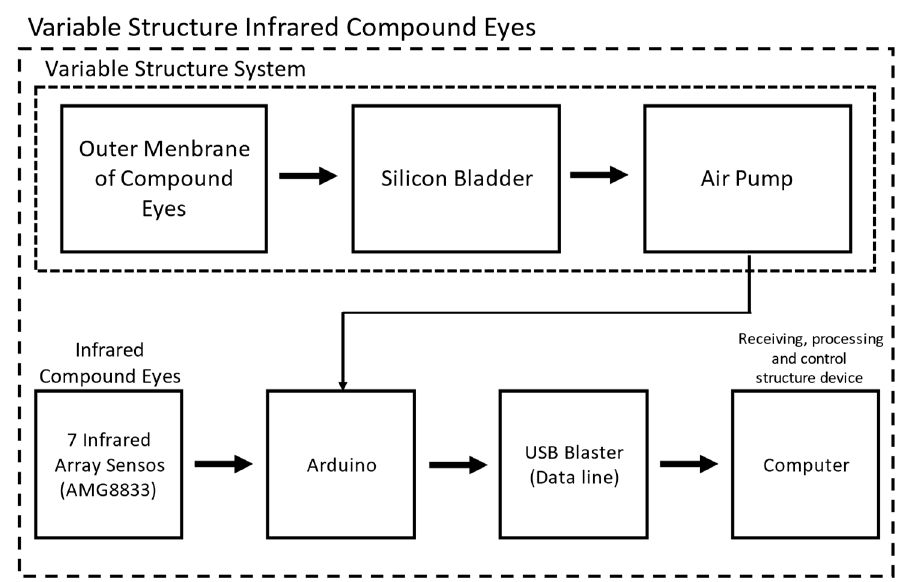
Figure 13. Architecture of the VSICE system: seven infrared array sensors are attached to the SAM, the outer membrane controls the internal air pressure of the SAM through an air pump to change the array surface, and the infrared array sensors are directly connected to Arduino. Data are transmitted in real time through IIC to the computer for processing.